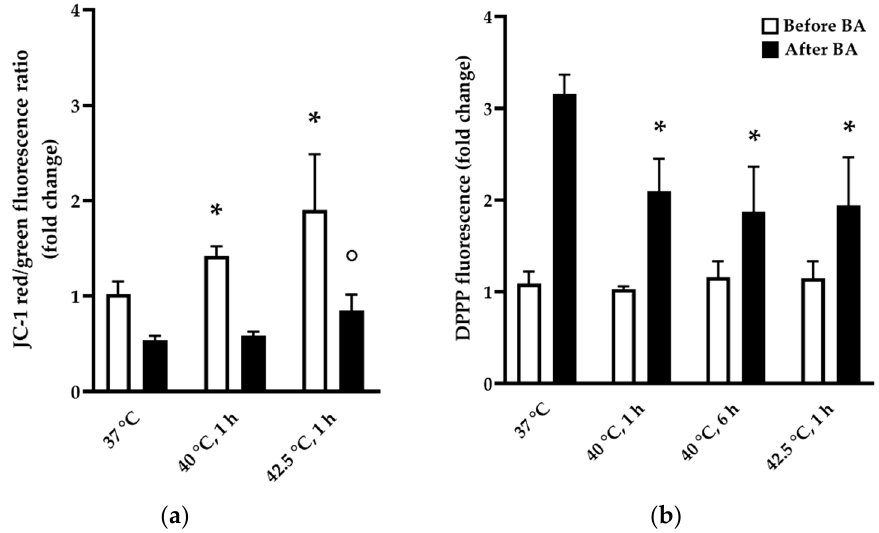
Figure 3. The effect of heat priming on mitochondrial membrane potential and lipid peroxidation of CHO cells. ( a ) Change in mitochondrial membrane potential measured by fluorescent JC-1 dye. Cells were primed at 40 °C for 1 h and 42.5 °C for 1 h, then fluorescence was read before (empty bars) and after (solid bars) addition of a challenging dose of 95 mM BA. Fold change was calculated in comparison to non-treated 37 °C. ( b ) CHO cells were primed at 40 °C for 1 h and 6 h and at 42.5 °C for 1 h, followed by lipid peroxidation-sensitive DPPP fluorescence measurement (empty bars). After heat pretreatments a challenging dose of 95 mM BA was introduced to the cells (solid bars). In ( a , b ), all data represent the means ± SD; n ≥ 9, p < 0.05 was considered statistically significant. Paired t -test was used for statistical comparisons. In (a), * and ° denote statistically significant difference compared to 37 °C and 37 °C + BA, respectively, while in ( b ), significant difference was compared to 37 °C + BA and denoted by *.